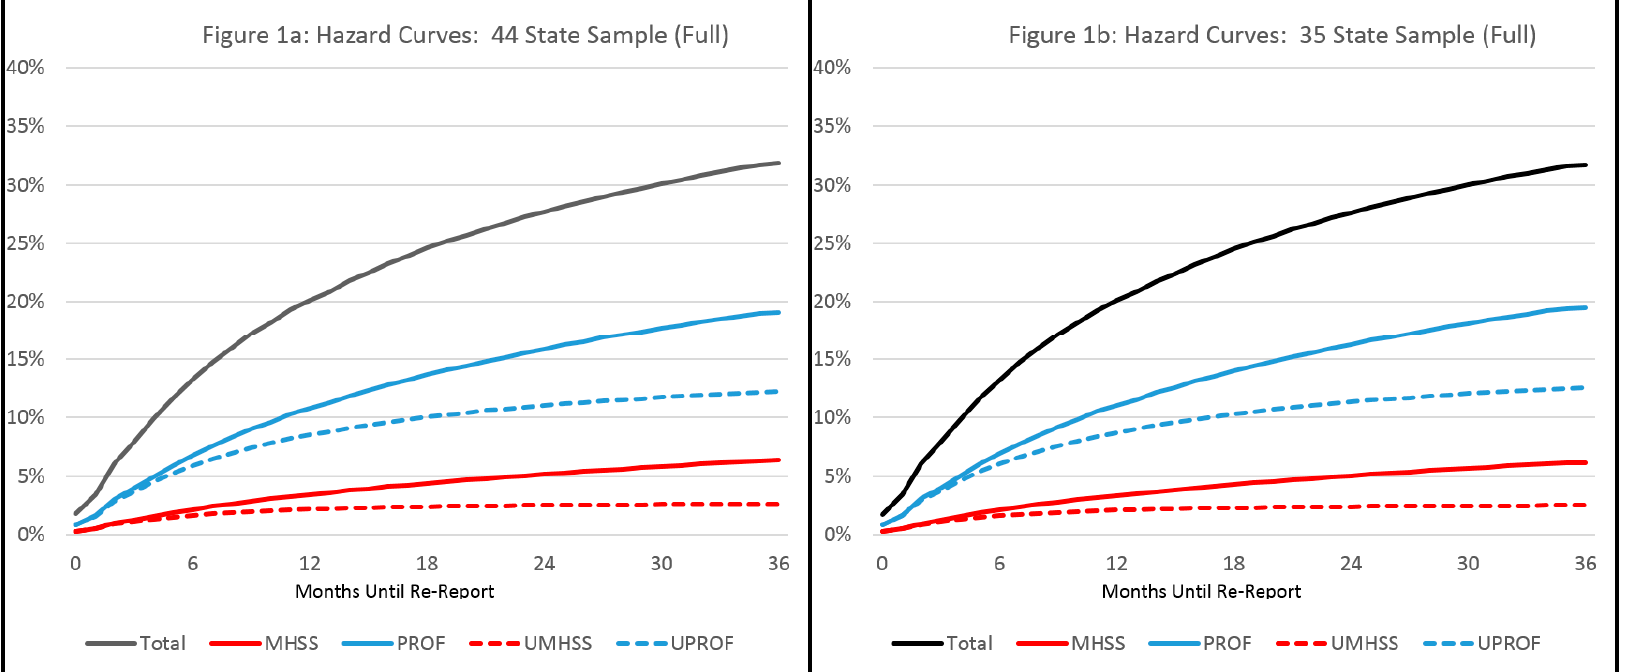
Figure 1. Hazard curves, percentage with re ‐ report by re ‐ reporter type: ( a ) full (44 State) sample; ( b ) 35 state sample. Note: “MHSS” indicates a mental health or social services reporter, “PROF” indicates any professional reporter (including MHSS), the prefix “U” indicates that the source was uniquely from that reporter type (e.g. “UMHSS” means reports were made only by a MHSS source or sources).